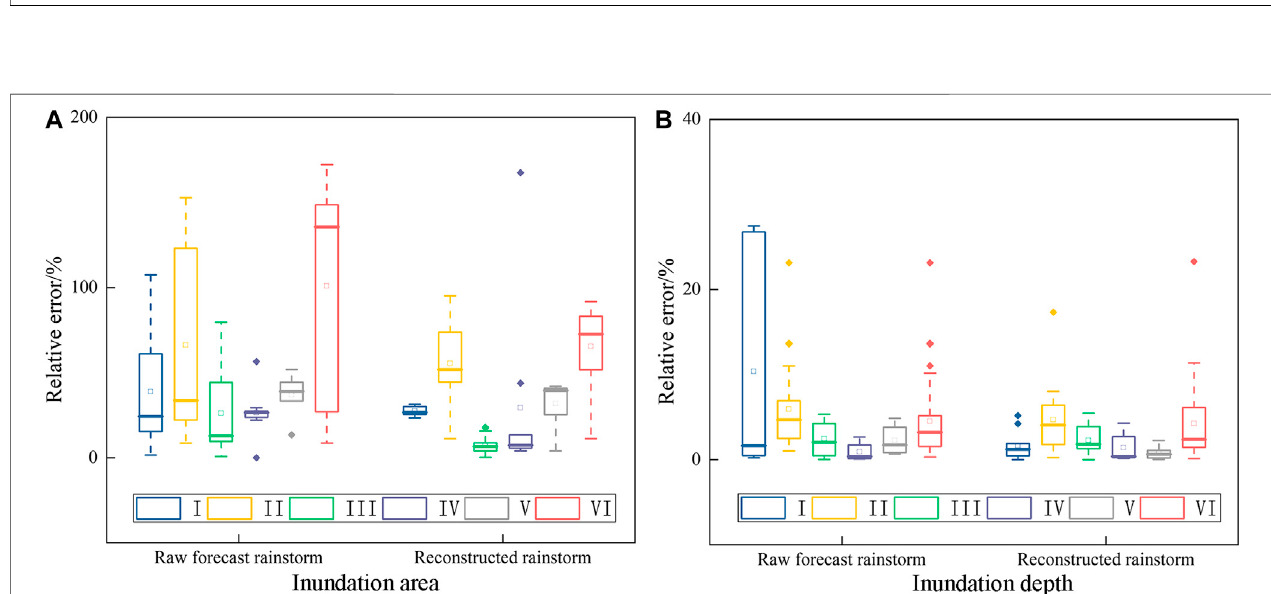
FIGURE 9 | The RE of inundation area and depth simulation by using different input data.